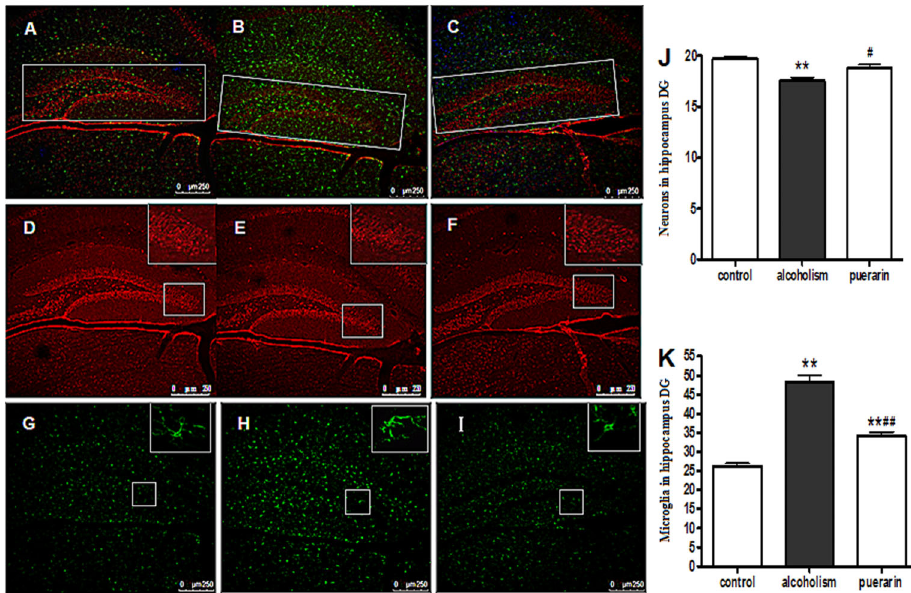
Figure 4. Detection of neuron and microglia cells in the hippocampus of mice by immunohistochemical staining. A - C , Neu-N and Iba-1 immunofluorescence staining in the hippocampus of the control, model, and puerarin groups (10 6 ). D - F , Hippocampal neurons of each group. G-I , Hippocampal microglia of each group. J , Number of neurons in the hippocampus of each group. K , Number of microglia cells in the hippocampus of each group. DG: dentate gyrus. **P , 0.01 vs control group; # P , 0.05, ## P , 0.01 vs model group (one-way